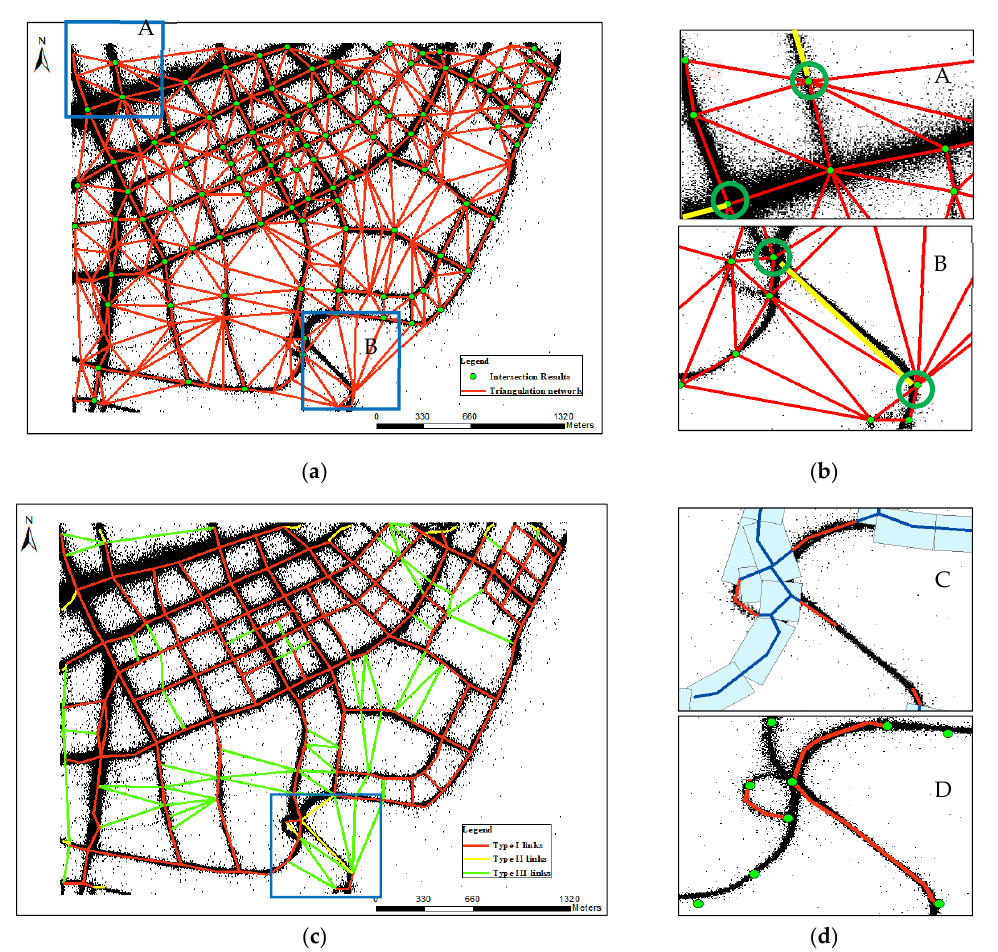
Figure 5. Links identification. ( a ) Initial links identification network; ( b ) missing true links due to the largest empty circle criterion and being located in the edge area; ( c ) preliminary identification results; ( d ) optimizing example.